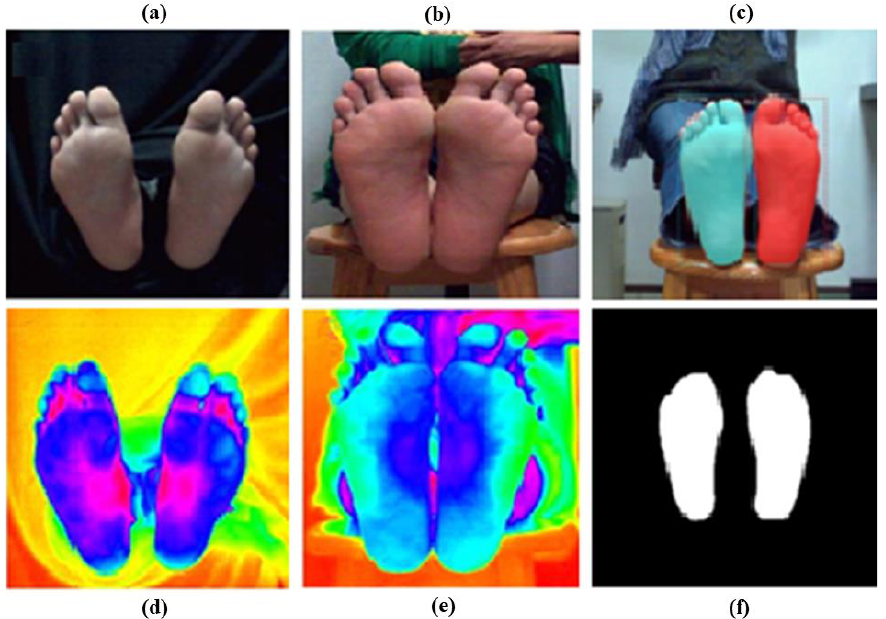
Figure 10. Images captured by the IRT FLUKE TI32 camera with two different backgrounds for the creation of the databases. ( a ) Image of feet with homogeneous black background, ( b ) image of feet with non-homogeneous background, ( c ) adjustment of Mask R-CNN to binary classification system (foot-bottom), ( d ) thermographic image corresponding to the capture of item a, ( e ) Thermographic image corresponding to the capture of item b and ( f ) segmentation of plantar zones in an uncontrolled background environment.